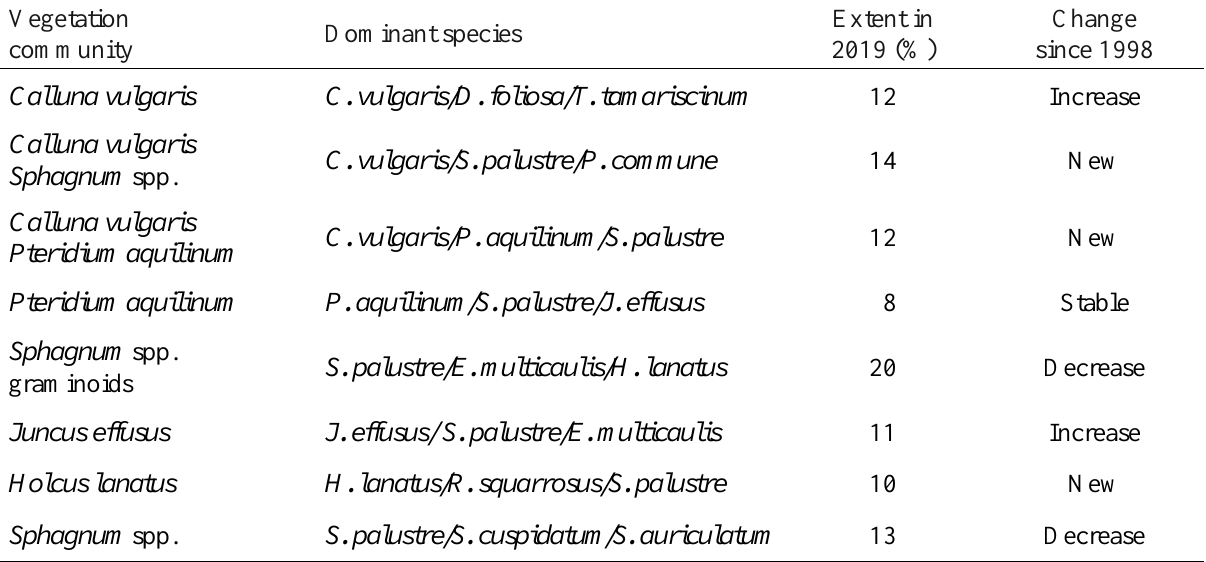
Table 5. Comparison of the vegetation communities recorded at the Criação do Filipe peatland complex between surveys 21 years apart. Data from Mendes (1998) and this study